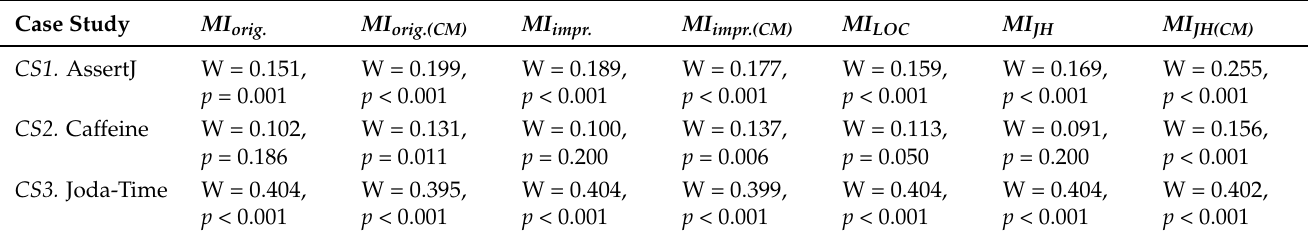
Table 11. Kolmogorov–Smirnov normality test.